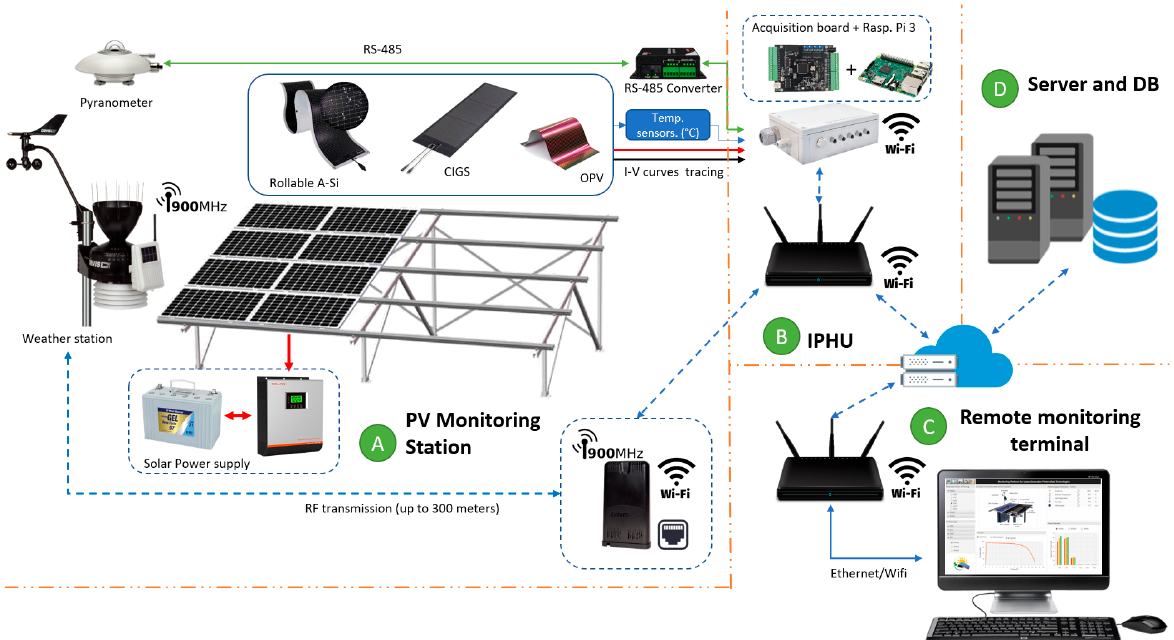
Figure 1. Platform architecture for outdoor real-time characterization of PV panels and OPV mini modules.